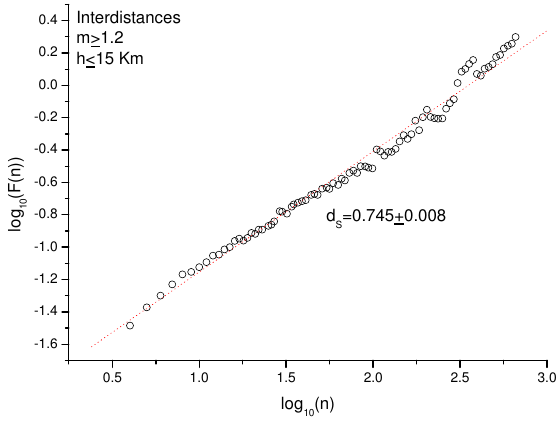
Fig. 7. p-values for the interevent time series changing the threshold magnitude and depth.